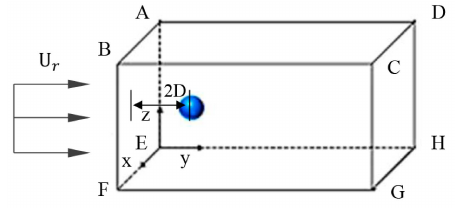
Figure 1. Schematic of the computational